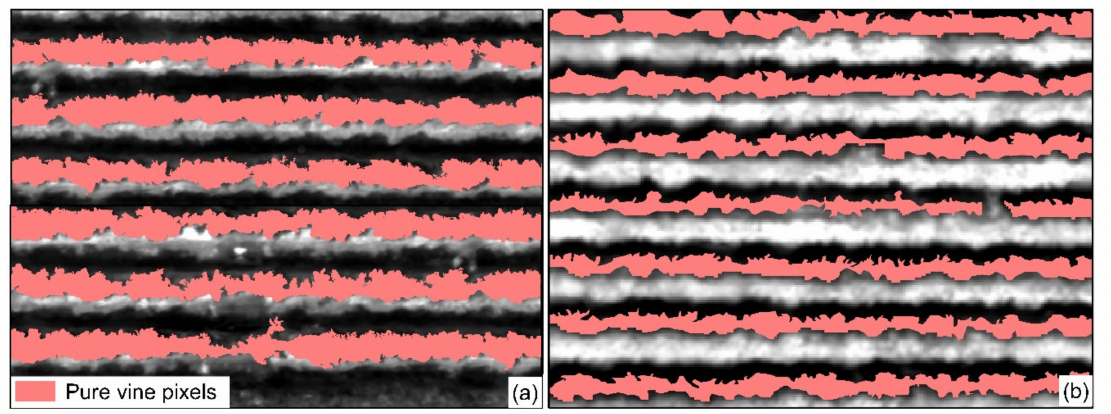
Figure 4. The thermal images showing the extraction of pure grapevine pixels to estimate canopy temperature (red polygons). ( a ) Example of thermal orthomosaic acquired with ICI camera. ( b ) Example of thermal acquired obtained with FLIR